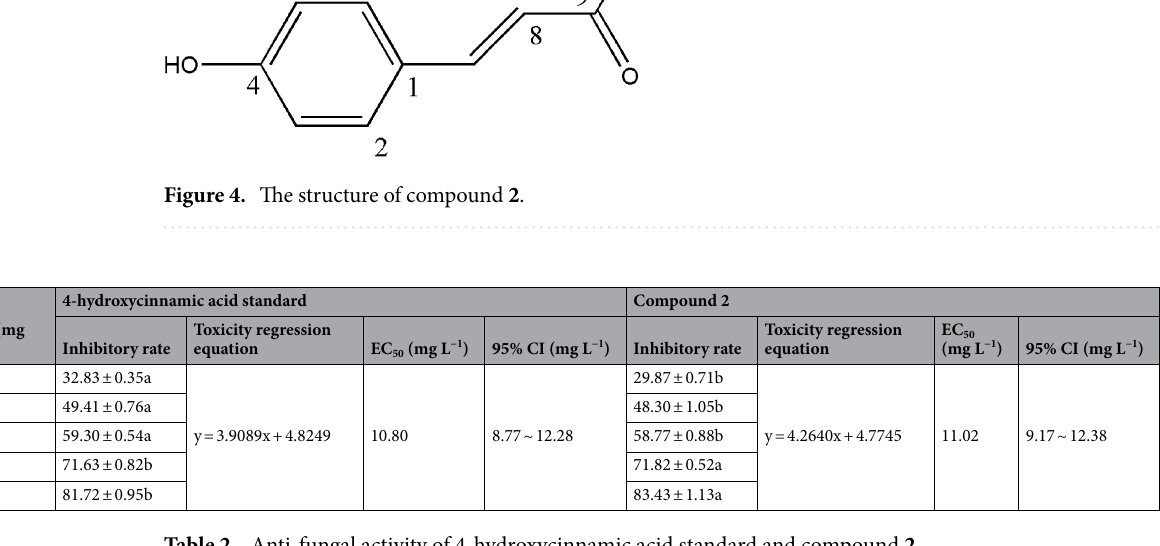
Table 2. Anti-fungal activity of 4-hydroxycinnamic acid standard and compound 2